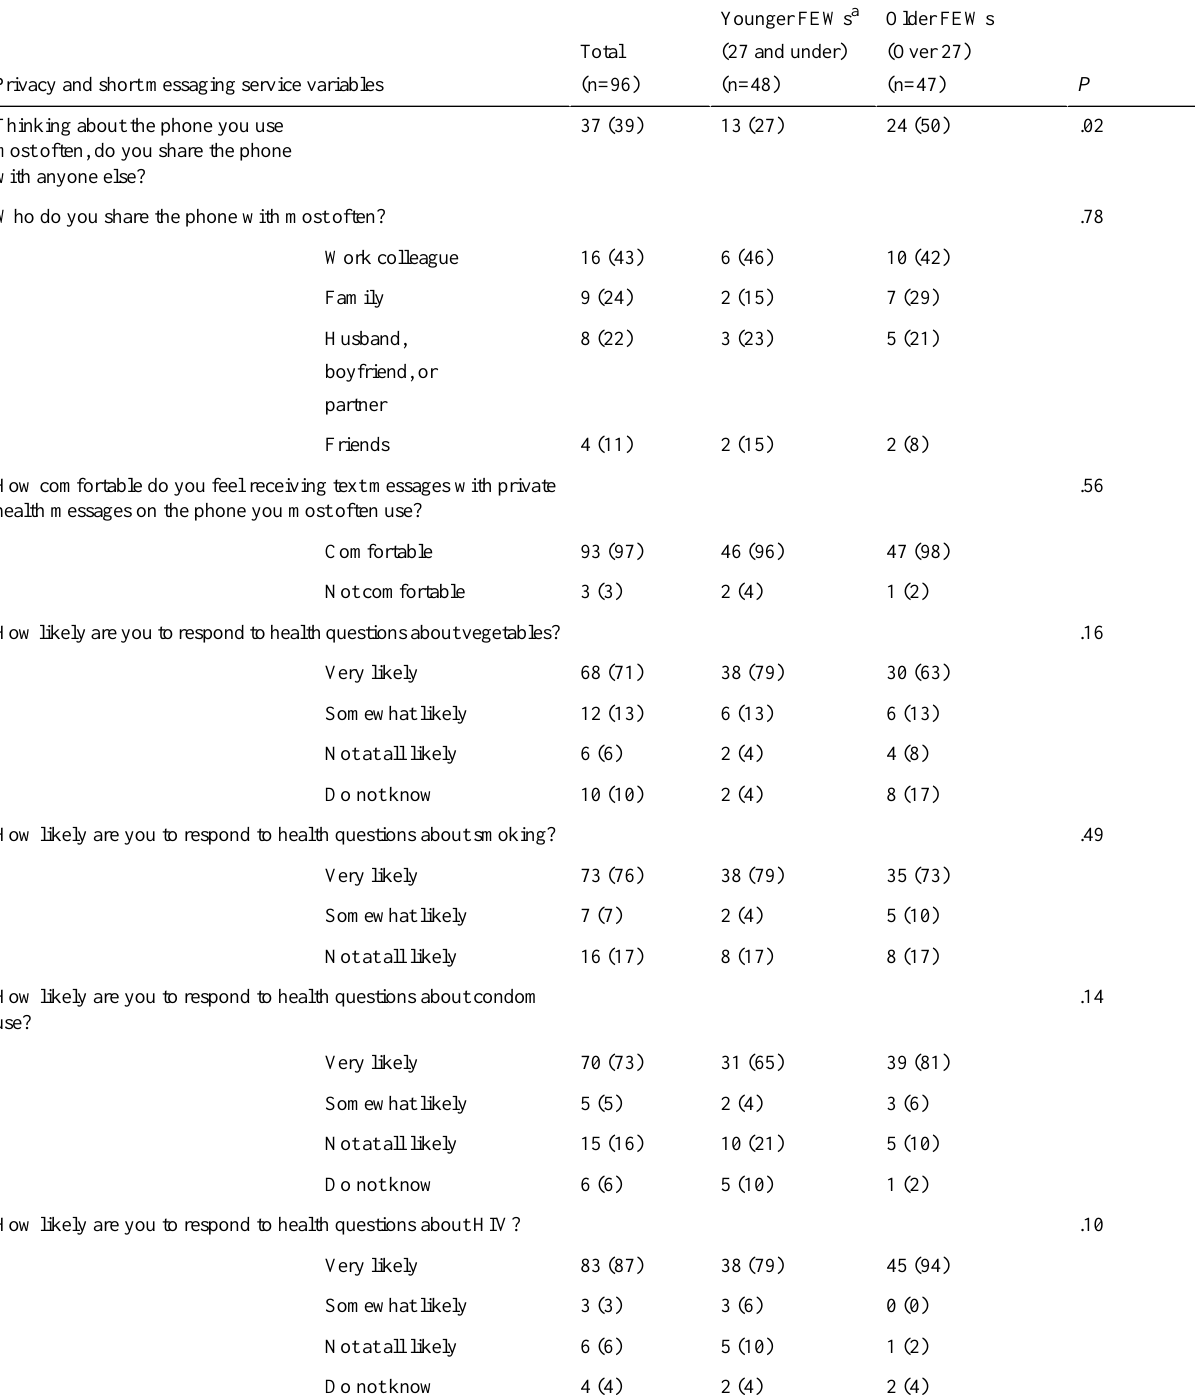
Table 4. Privacy and short messaging service of study participants by age group